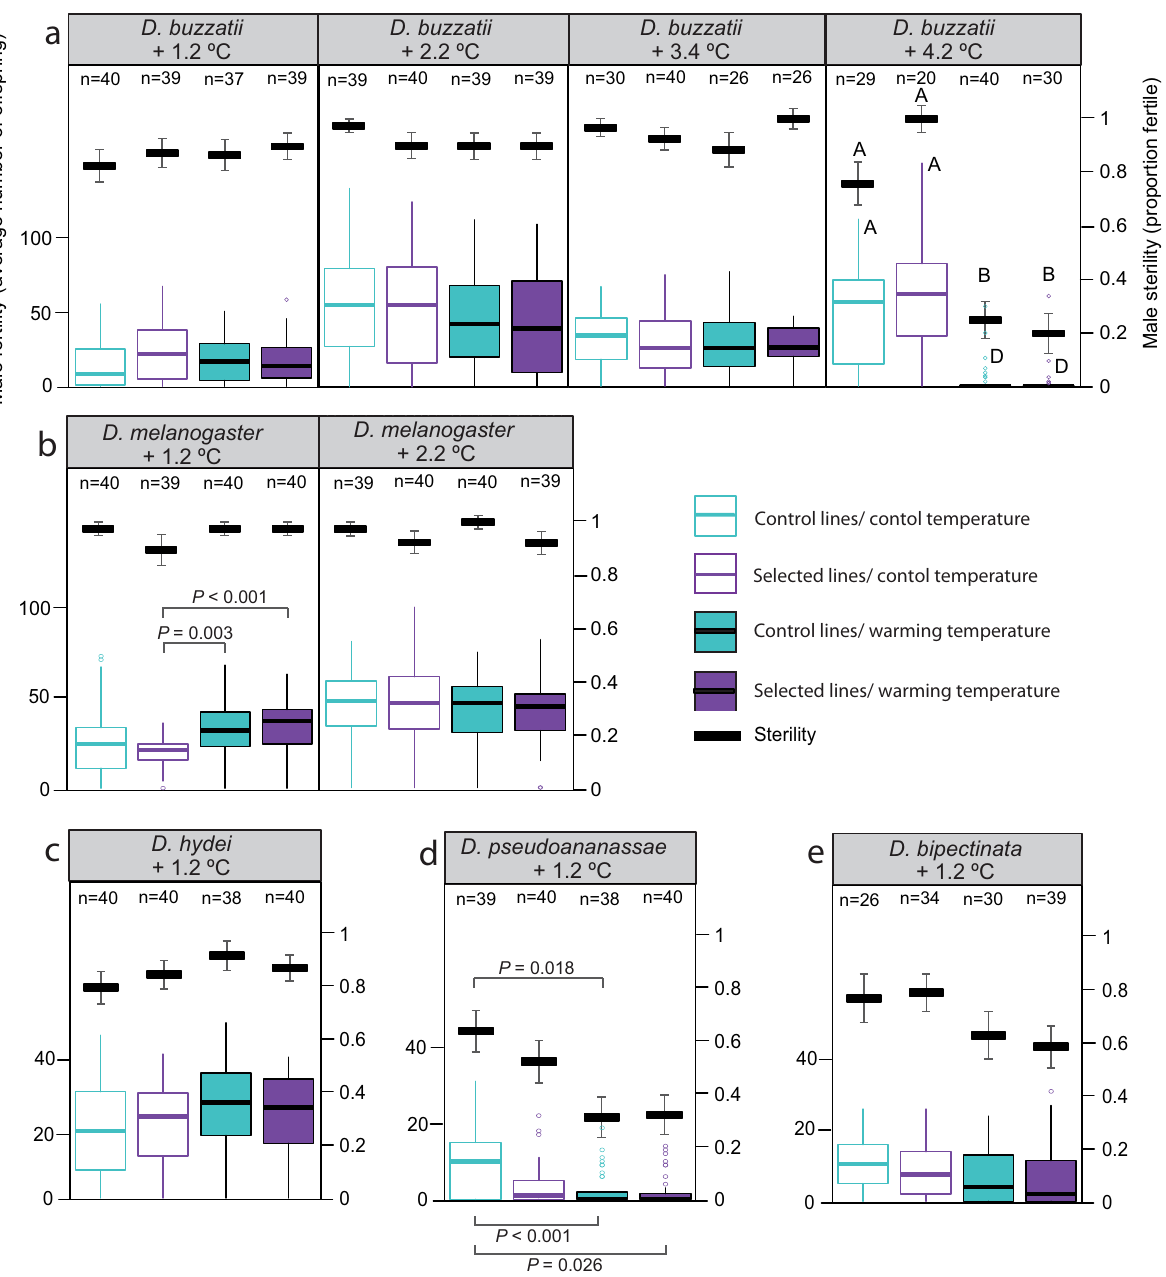
Fig. 4 The response of male sterility and fertility to gradual experimental warming in fi ve species of Drosophila . Mean male sterility ± SEM (proportion of fertile males, solid black dash) and fertility (number of offspring, coloured boxplots denoting the median (solid horizontal lines), upper and lower quartiles (boxes), 1.5× interquartile range (vertical lines) and outliers (circles)) across four replicate control (aqua) and four replicate selected lines (purple) of a widespread D. buzzatii after 1.2, 2.2, 3.4 and 4.2 °C of warming; b widespread D. melanogaster after 1.2 and 2.2 °C of warming; c widespread D. hydei after 1.2 °C of warming; d tropical D. pseudoananassae after 1.2 °C of warming; and e tropical D. bipectinata after 1.2 °C of warming. Fertility/sterility was estimated by reciprocally transplanting eggs from control and selected lines to developmental temperatures re fl ecting both the control thermal regime (26 ± 3 °C, open boxes) and the warming thermal regime (solid boxes) at the generation of testing (e.g., 27.2 ± 3 °C after 1.2 °C of warming) and estimating male fertility/sterility at those developmental temperatures. Signi fi cant differences (two-sided Tukey post hoc test) between selection lines/developmental temperature within a generation of warming are shown by lines with corresponding P values or differing letters ( a versus b : P < 0.01, a versus d : P < 0.001). n = total number of individuals per temperature/treatment. Source data are provided as a Source Data fi